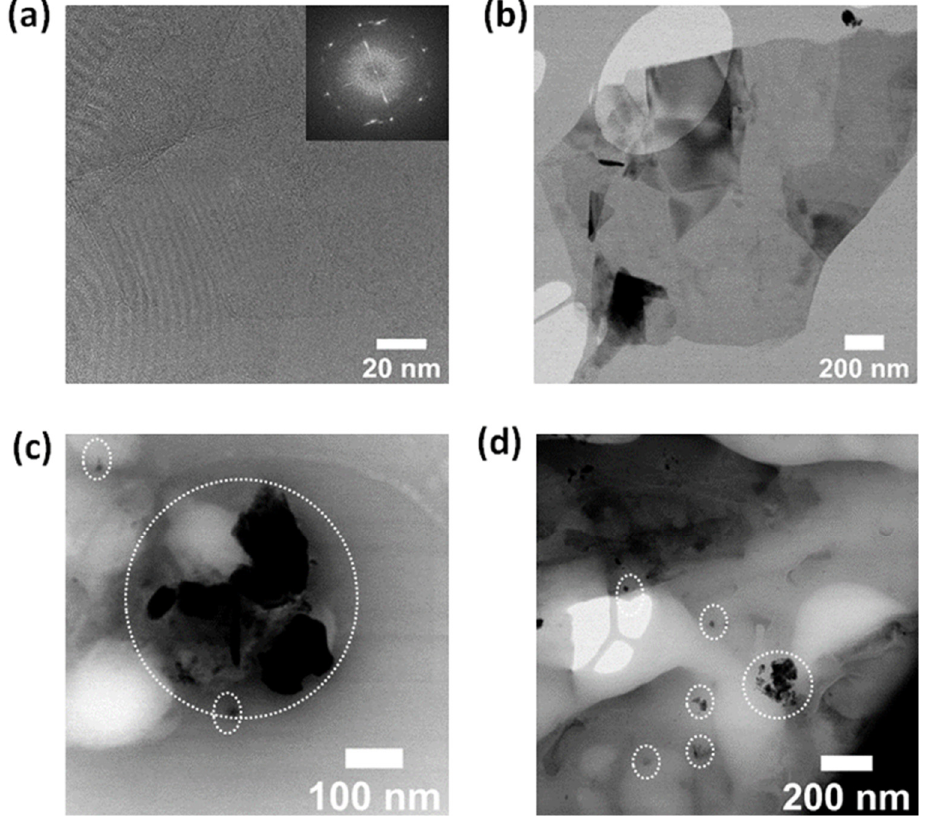
Figure 4. High-resolution transmission electron microscopy (HRTEM) images of the GNSs transferred onto TEM grids before ( a , b ) and after functionalization with Co − Por ( c ) and Fe − Phc ( d ). FFT image (in the Figure 4 a inset).